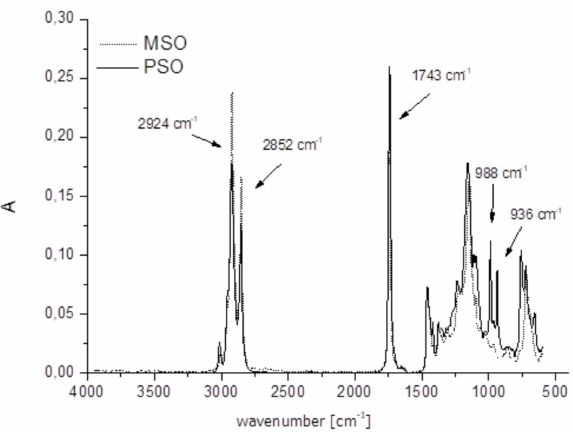
Figure 3. MIR spectra (4000–600 cm − 1 ) of PSO and MSO. (A,